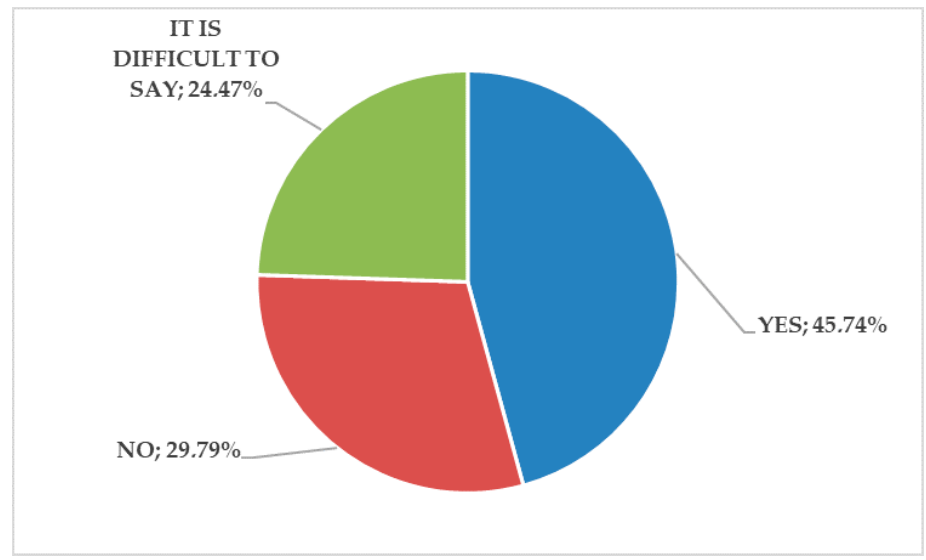
Figure 6. Distribution of responses to the question about the perception of the institute as an innovative place to work. Source: own elaboration based on the results of questionnaire surveys.